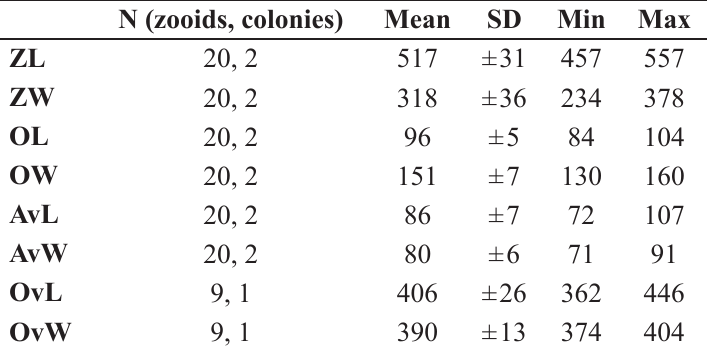
Table 5. Measurements in µm of Microporella ordo Brown, 1952, Recent, Spirits Bay, New Zealand; NIWA 144880,